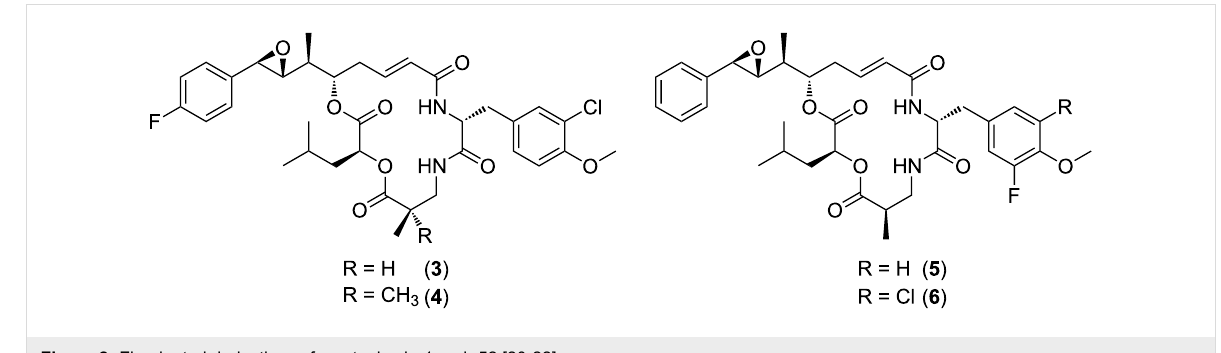
Figure 2: Fluorinated derivatives of cryptophycin-1 and -52